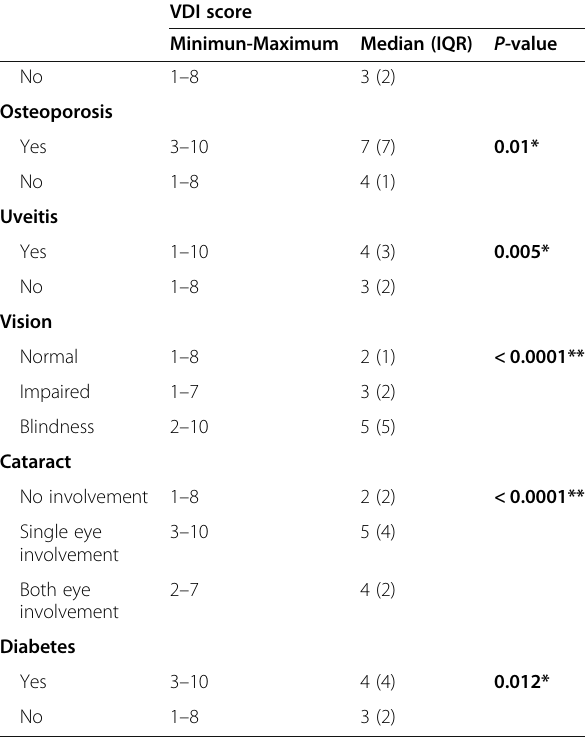
Table 3 Comparison of Vasculitis Damage Index (VDI) with respect to demographic and clinical manifestations